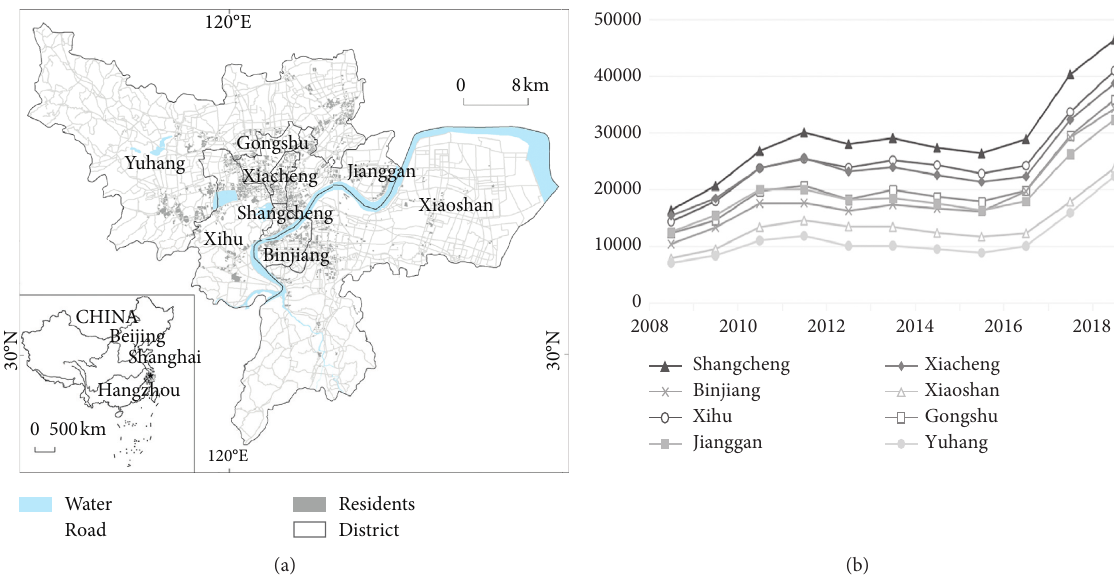
Figure 2: Study area and housing price distribution in Hangzhou. (a) Study area. (b) Housing price distribution (Rmb/m 2